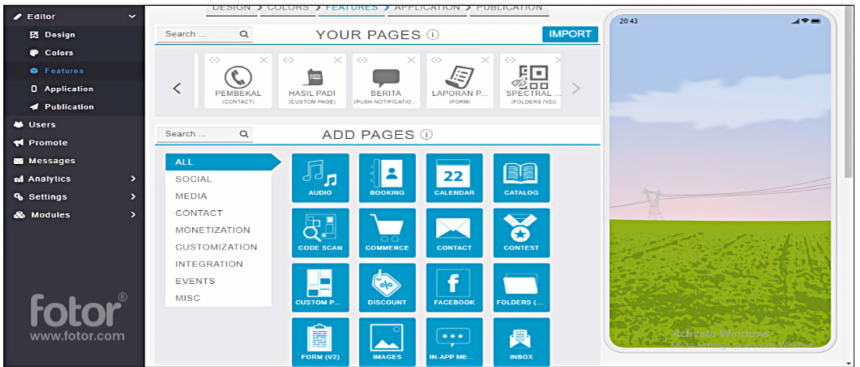
Figure 5. The application Editor tool and Feature menu in MasterAppBuilder Application. (PEM- BEKAL: SUPPLIER, HASIL PADI: RICE YIELD, BERITA: NEWS, LAPORAN: